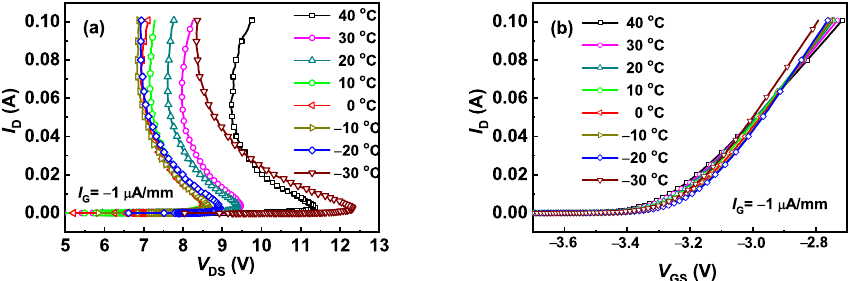
Figure 3. Temperature -dependent BV ON loci of the 8 × (0.35 × 100) µ m 2 AlGaN/GaN HEMTs. A constant current (1 µ A/mm) is extracted from the gate while I D is swept from the OFF-state ( − I G ) to the ON-state. ( a ) V DS versus I D . ( b ) V GS versus I D